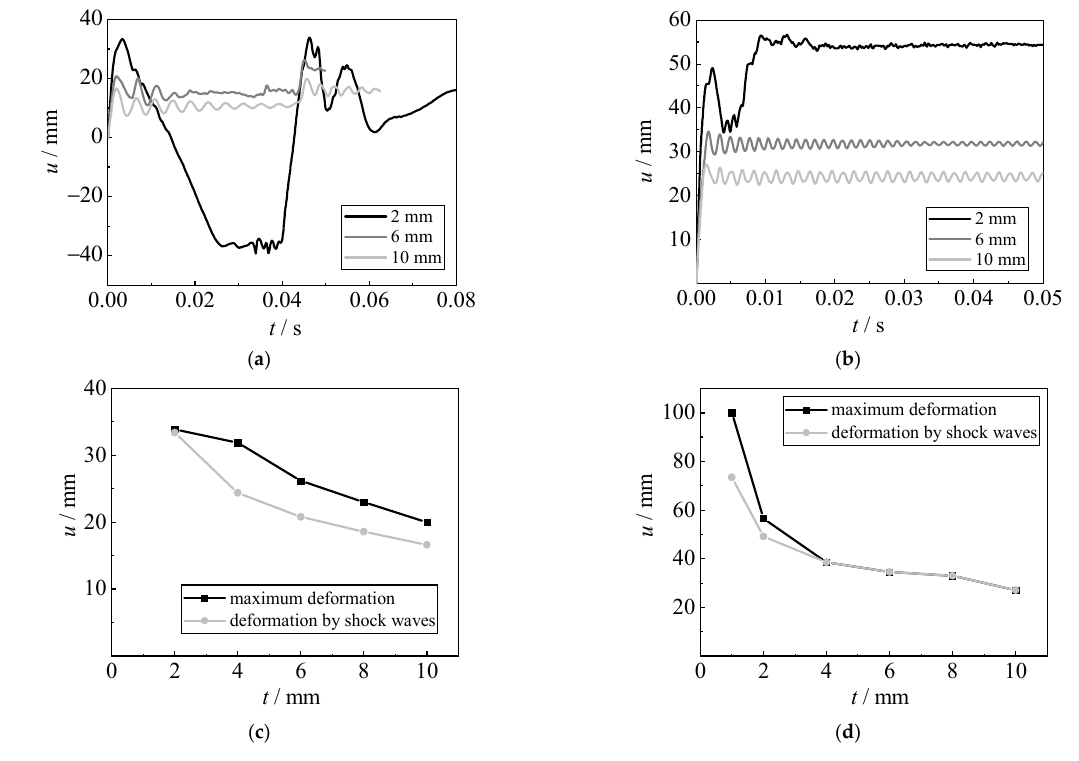
Figure 19. Effect of plate thickness. ( a ) Displacement time histories (5 g TNT). ( b ) Displacement time histories (10 g TNT). ( c ) Deformation (5 g TNT). ( d ) Deformation (10 g TNT).